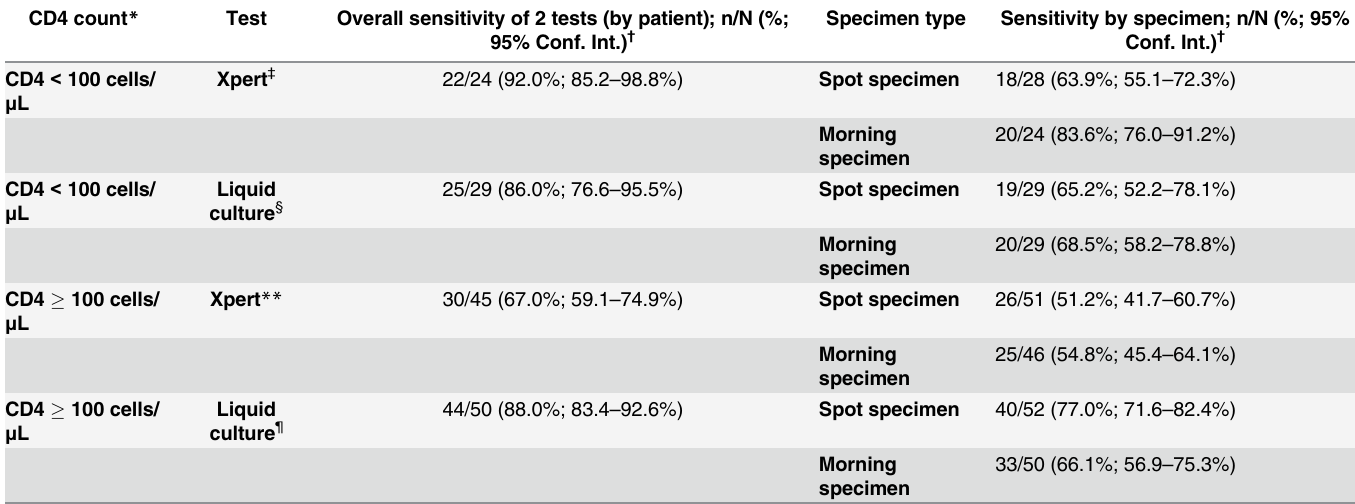
Table 3. Sensitivity of Xpert MTB/RIF and liquid culture of sputum specimens provided by TB cases (as compared to a composite gold standard), stratified by CD4 cell count of participant and specimen collection type (spot vs. morning). CD4 count